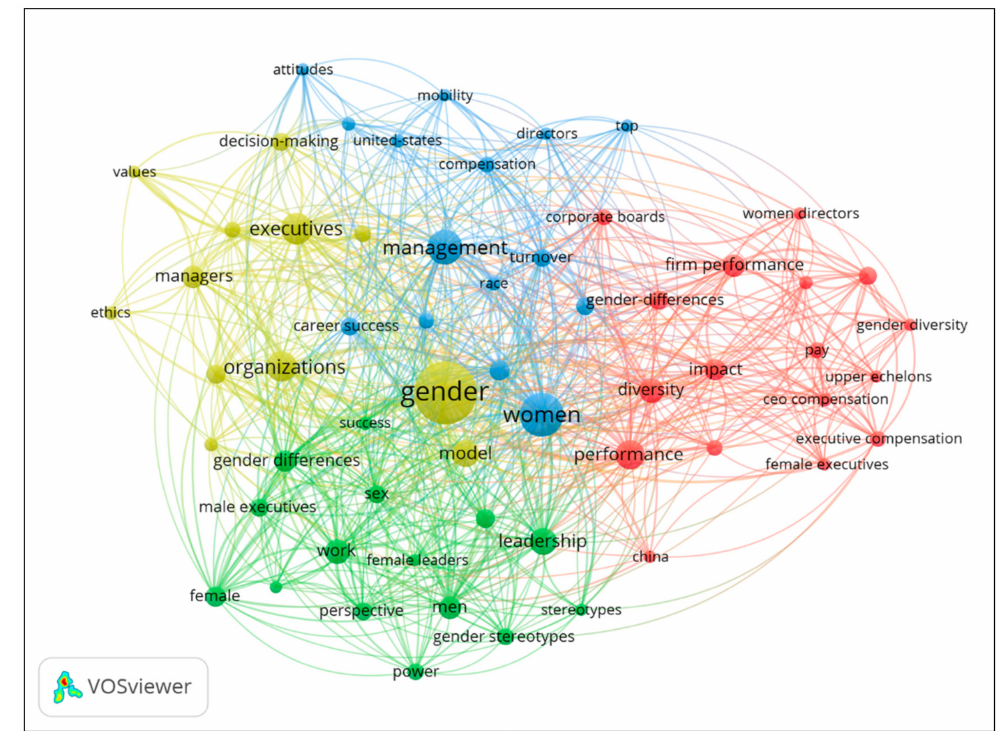
Figure 3. Network of links between keywords. Source: Prepared by the authors.